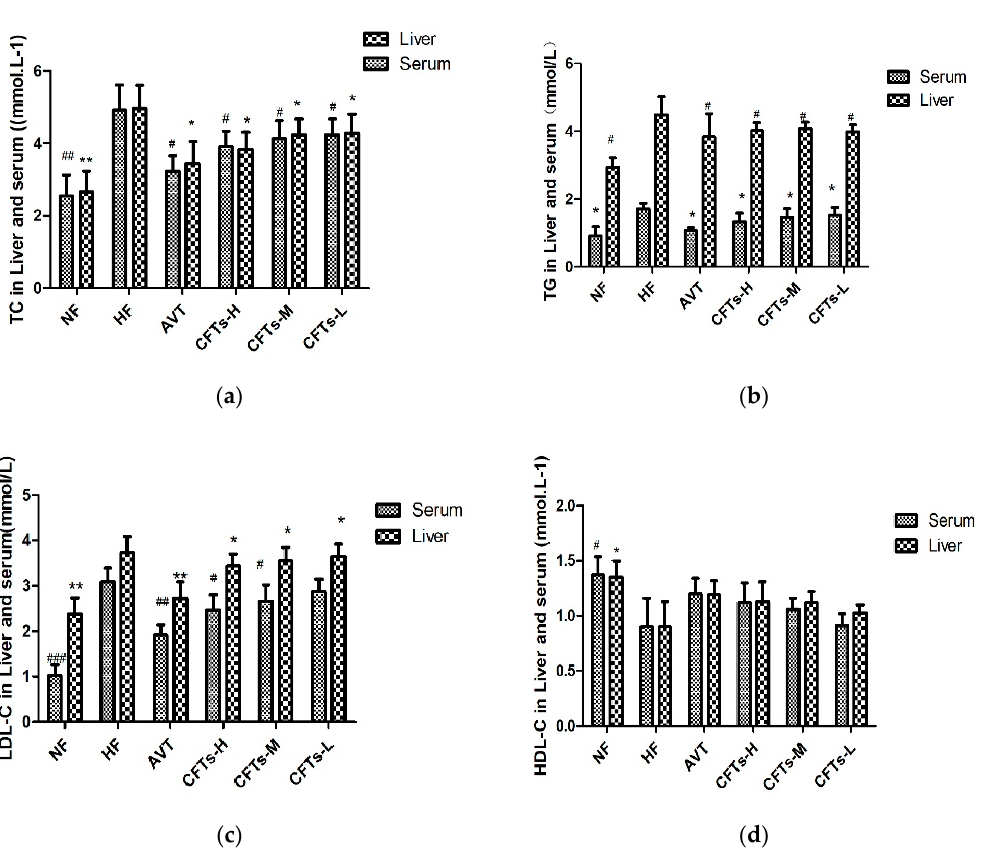
Figure 2. The effect of CFTs on lipid levels in the serum and liver. ( a ) TC levels in serum and liver; ( b ) TG levels in the serum and liver; ( c ) LDL-C levels in the serum and liver; ( d ) serum and liver HDL-C levels. These data are presented as the means ± SD ( n = 10). (* ,# ) Significant difference at p < 0.05, (** ,## ) significance difference at p < 0.01 and ( ### ) significance difference at p < 0.001 VS the HF group. Table 1. The serum, liver and fetal lipid levels in high-fat diet rats.